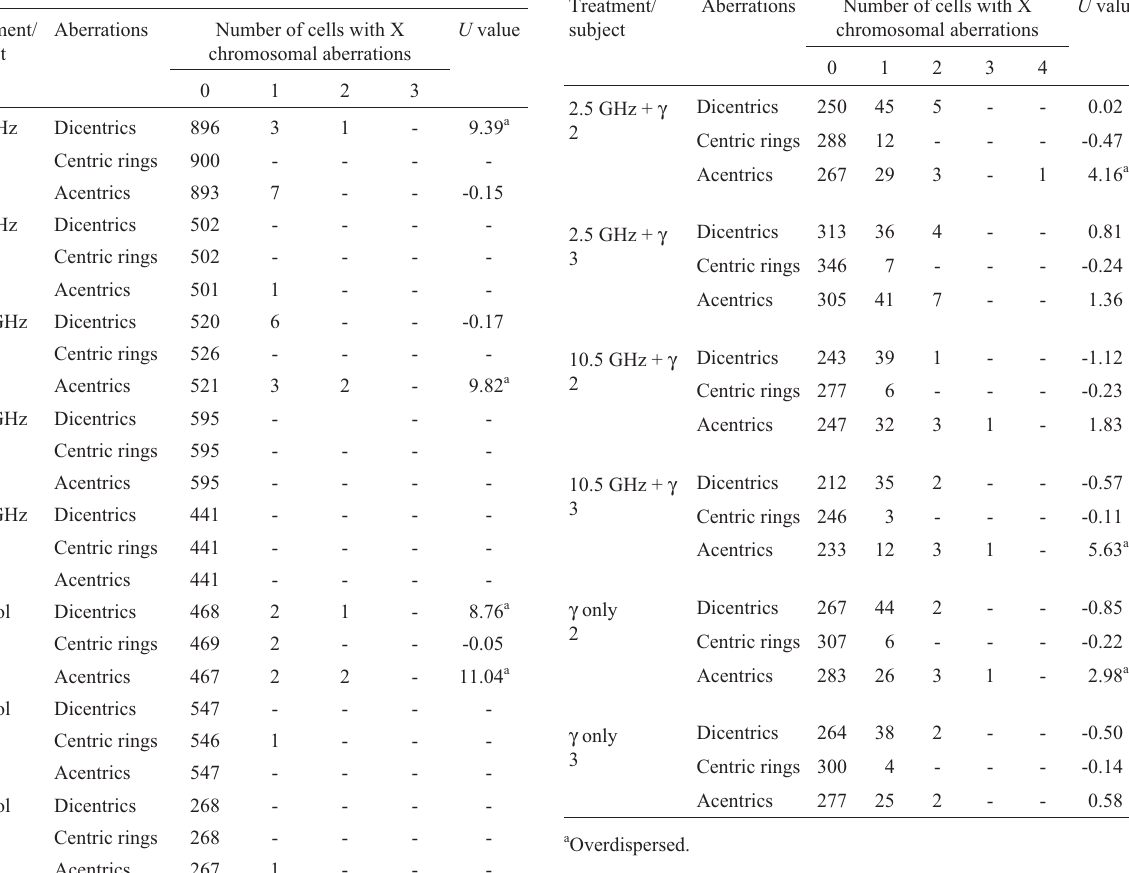
Table 2 - Distribution of the chromosome-type structural aberrations among the scored cells indicated in Table 1 and according to the treatment given.